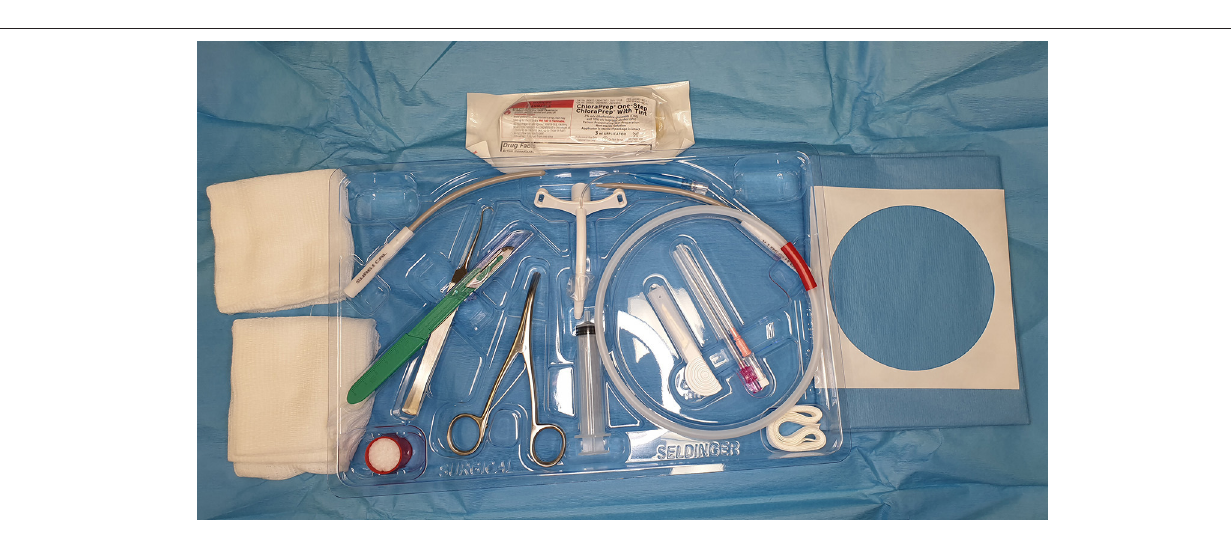
FIGURE 2 | Melker universal cricothyrotomy